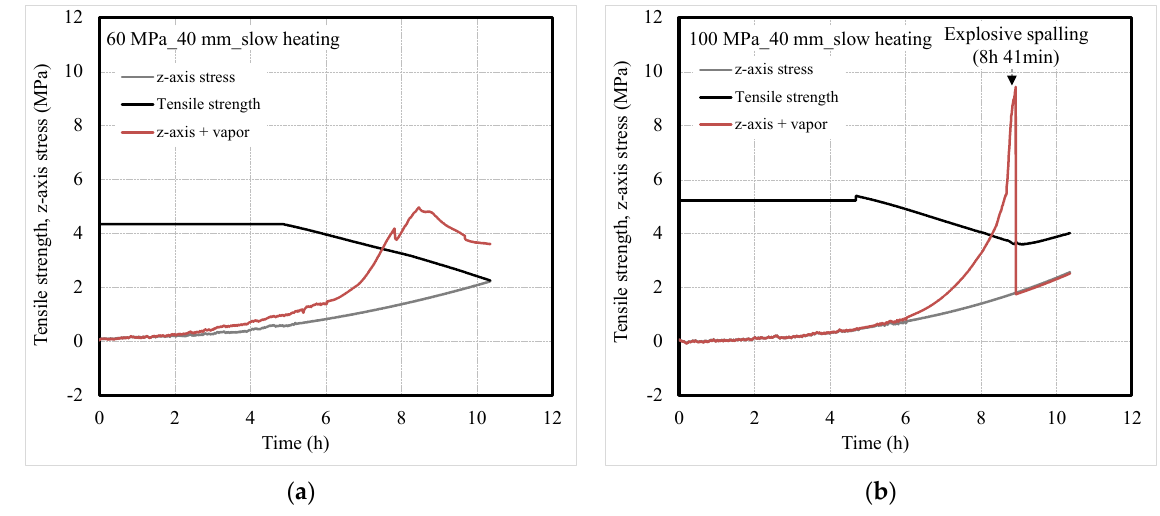
Figure 12. Tensile strength and z -axis stress of concrete under slow heating; ( a ) 60-MPa and ( b ) 100-MPa specimens.